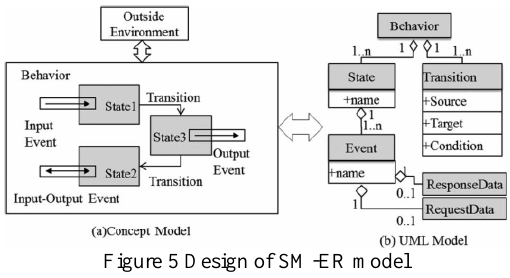
Figure 5 Design of SM-ER